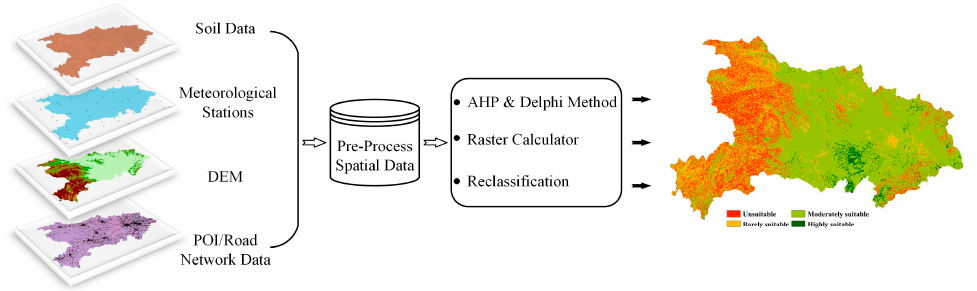
Figure 2. Workflow of FSE oriented by